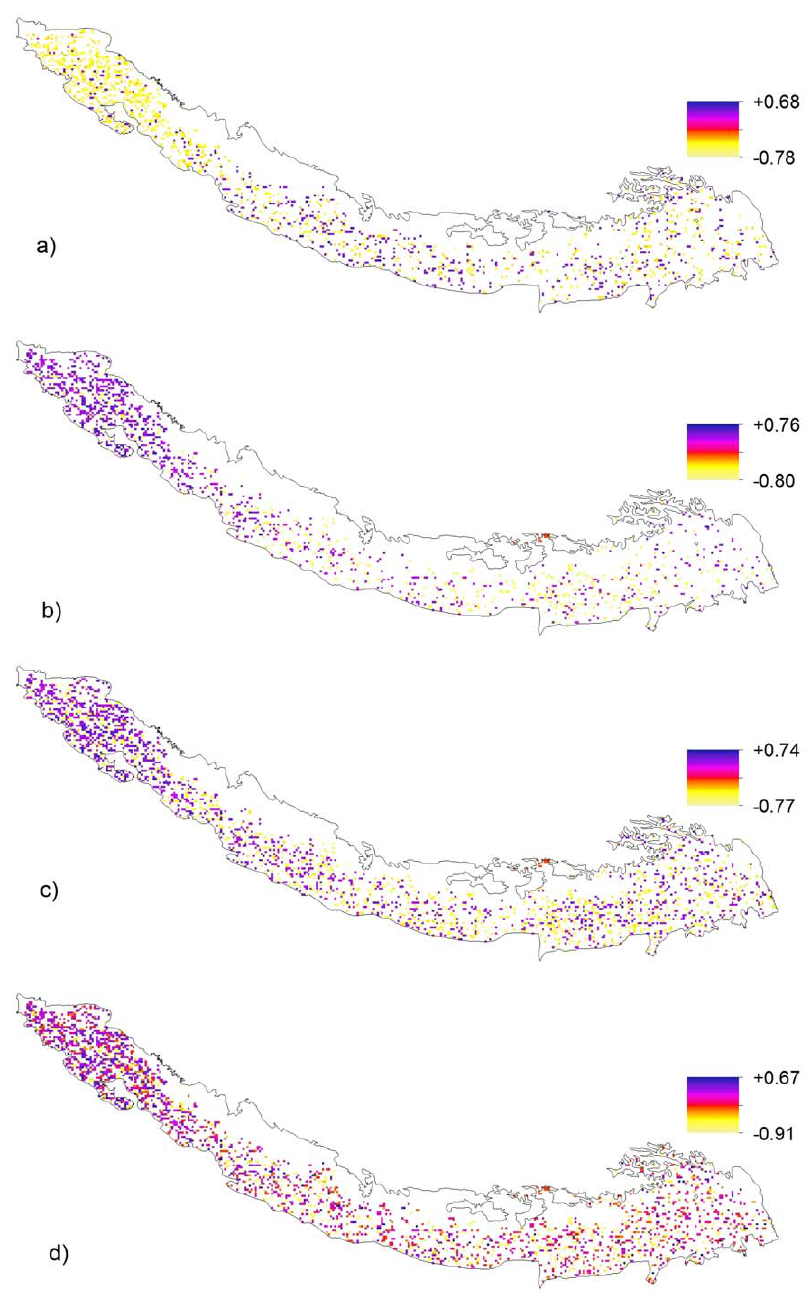
Figure 6. Spatial distribution of significant (P # 0.10) correlation coefficient of SOS and EOS related temperature and precipitation. a ) correlation coefficient between SOS with average temperature of March and April b ) correlation coefficient between SOS with cumulative precipitation of March and April c ) correlation coefficient between EOS with average temperature of August, September and October d ) correlation coefficient between EOS with precipitation of